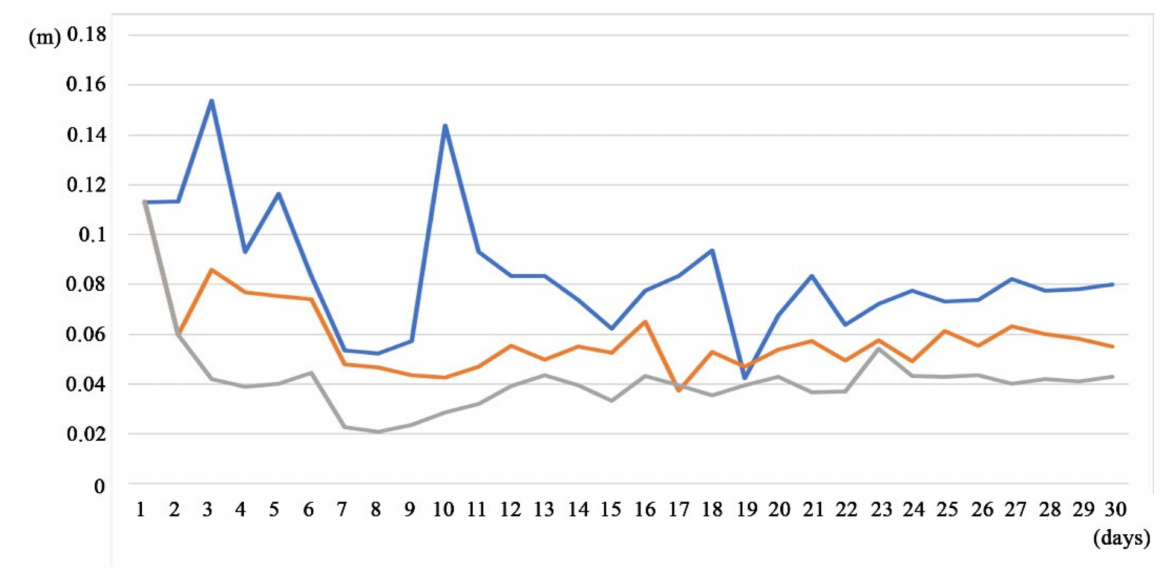
Figure 3. Root mean square deviation of the 24 h SLA forecast for 3 model runs. The blue line refers to the control model deviation; the orange line refers to the EnOI model deviation; the grey line refers to the GKF model